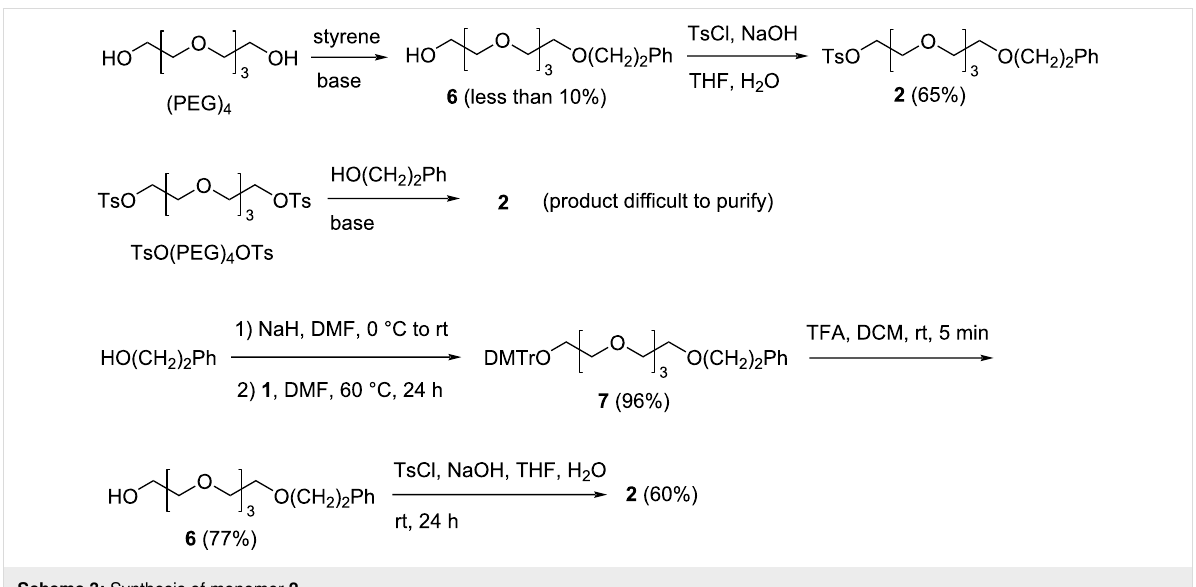
Scheme 3: Synthesis of monomer 2 .